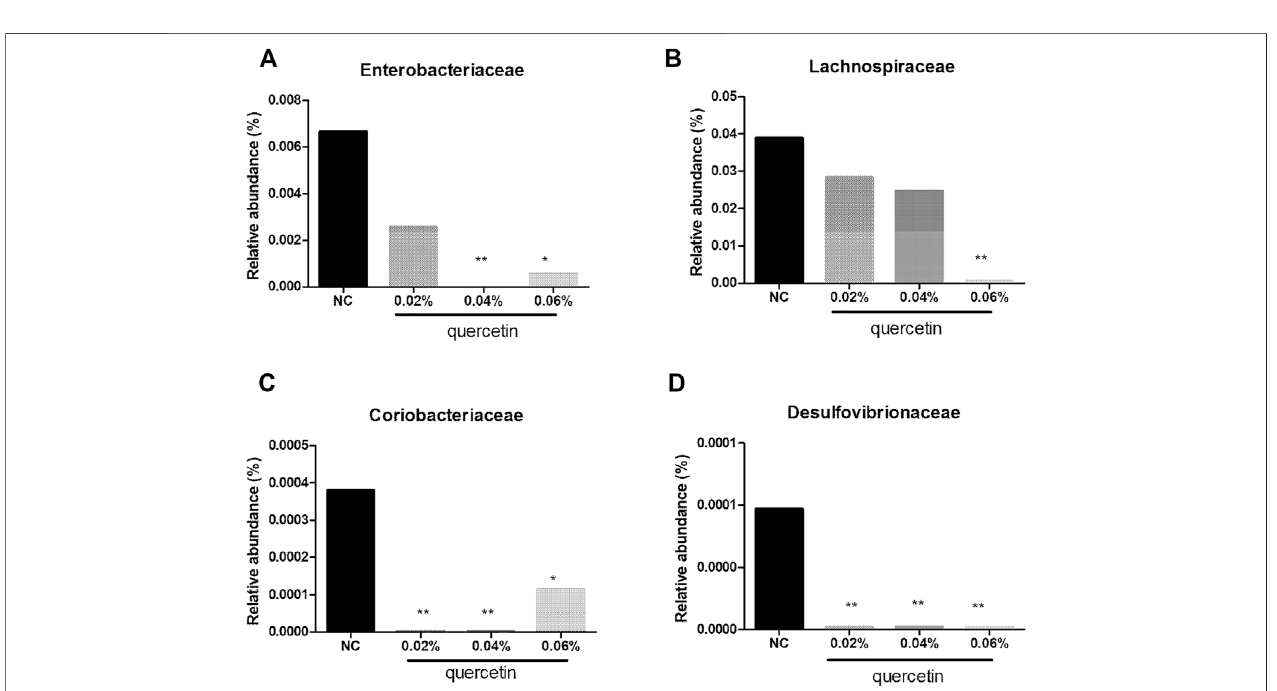
FIGURE3| EffectofquercetinonmicrobialrelativeabundanceintheileumofAAbroilersatthefamilylevel,NC(normalcontrolbroilers)andquercetin(0.02%,0.04, and 0.06%) groups. (A) Effect of quercetin on Enterobacteriaceae relative abundance in the ileum of AA broilers at the family level; (B) Effect of quercetin on Lachnospiraceae relative abundance in the ileum of AA broilers at the family level; (C) Effect of quercetin on Coriobacteriaceae relative abundance in the ileum of AA broilers at the family level; (D) Effect of quercetin on Desulfovibrionaceae relative abundance in the ileum of AA broilers at the family level. Data were statistically analyzed using one-way ANOVA with Duncan ’ s test. Values are expressed as means ± S.D., and n = 1 for all groups. * p < 0.05 and ** p < 0.01.